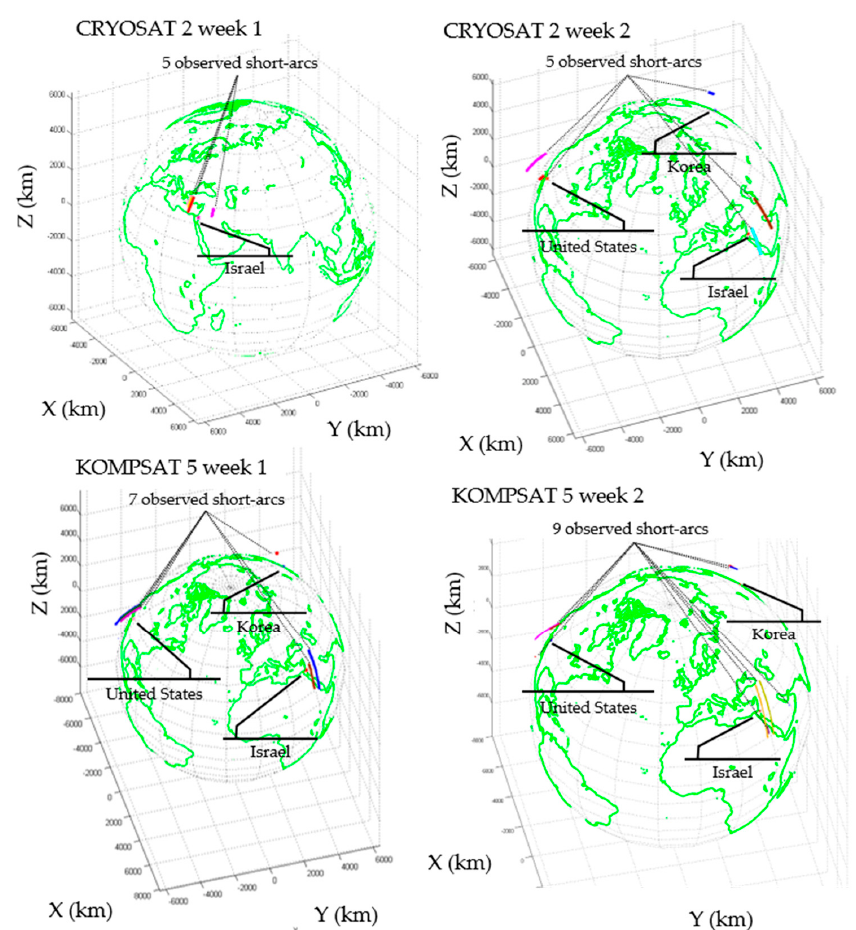
Figure 3. The three-dimensional (3D) orbit of CRYOSAT 2 and KOMPSAT 5 when the optical observations were performed by the OWL-Net. In Earth-Centered Fixed frame, the positions of the OWL-Net stations are marked with the names of the countries in which they were installed. The 3D orbit of CRYOSAT 2 and KOMPSAT 5 are presented as colored arcs.